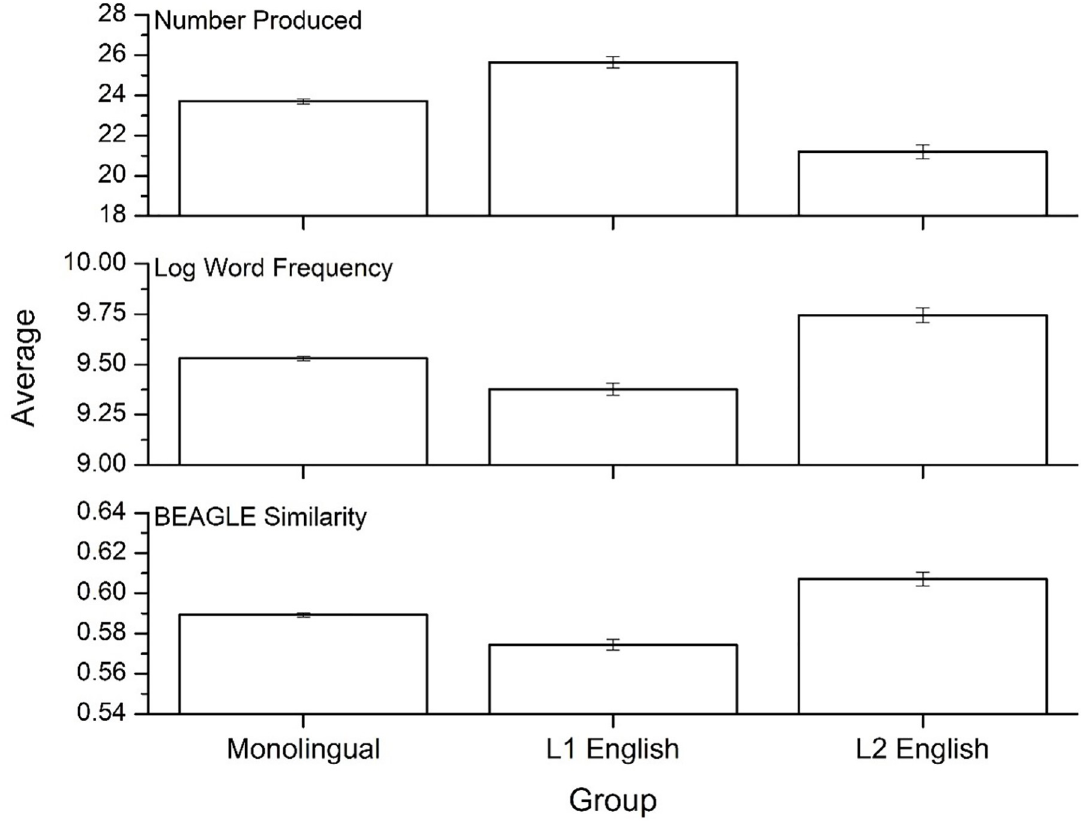
Fig 1. Means for the three psycholinguistic variables across the three language groups. Error bars represent 95% confidence intervals.